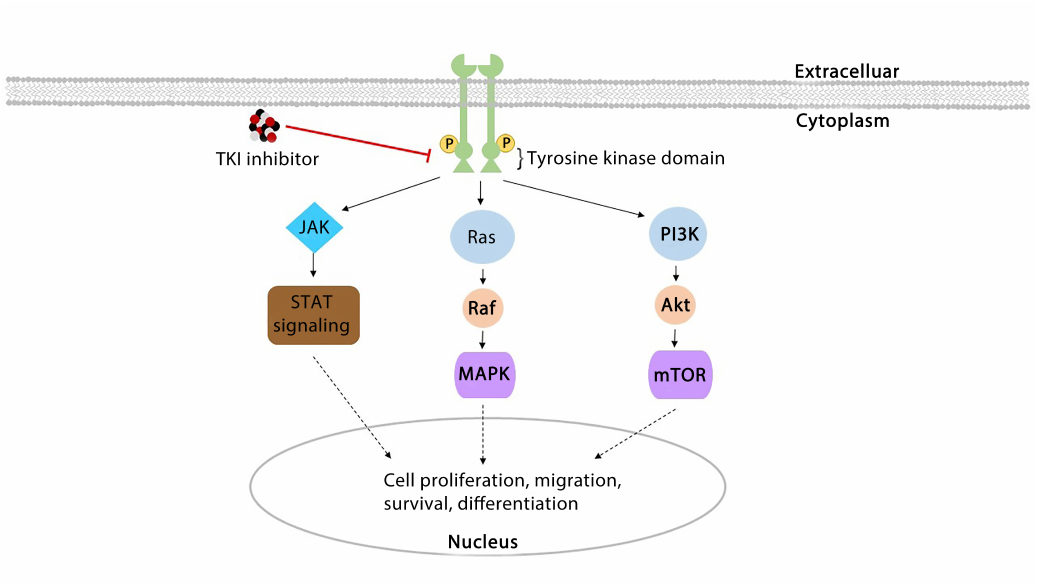
Fig. 1. Simplified cartoon showing signaling pathways of cell proliferation and site of Tyrosine Kinase inhibition